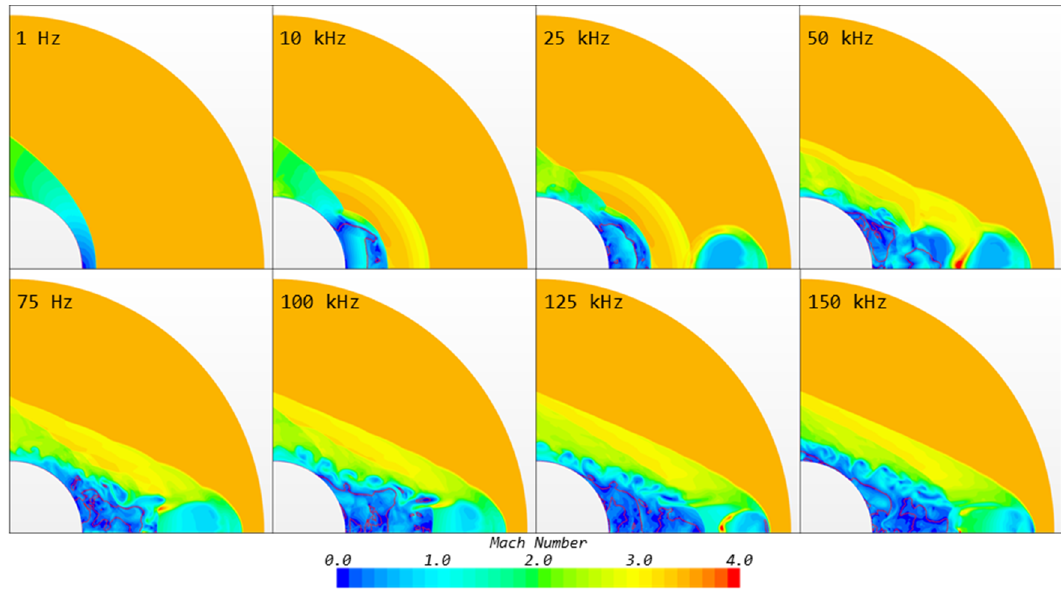
Figure 9. Mach number contours for various deposition frequencies at 250 μ s.